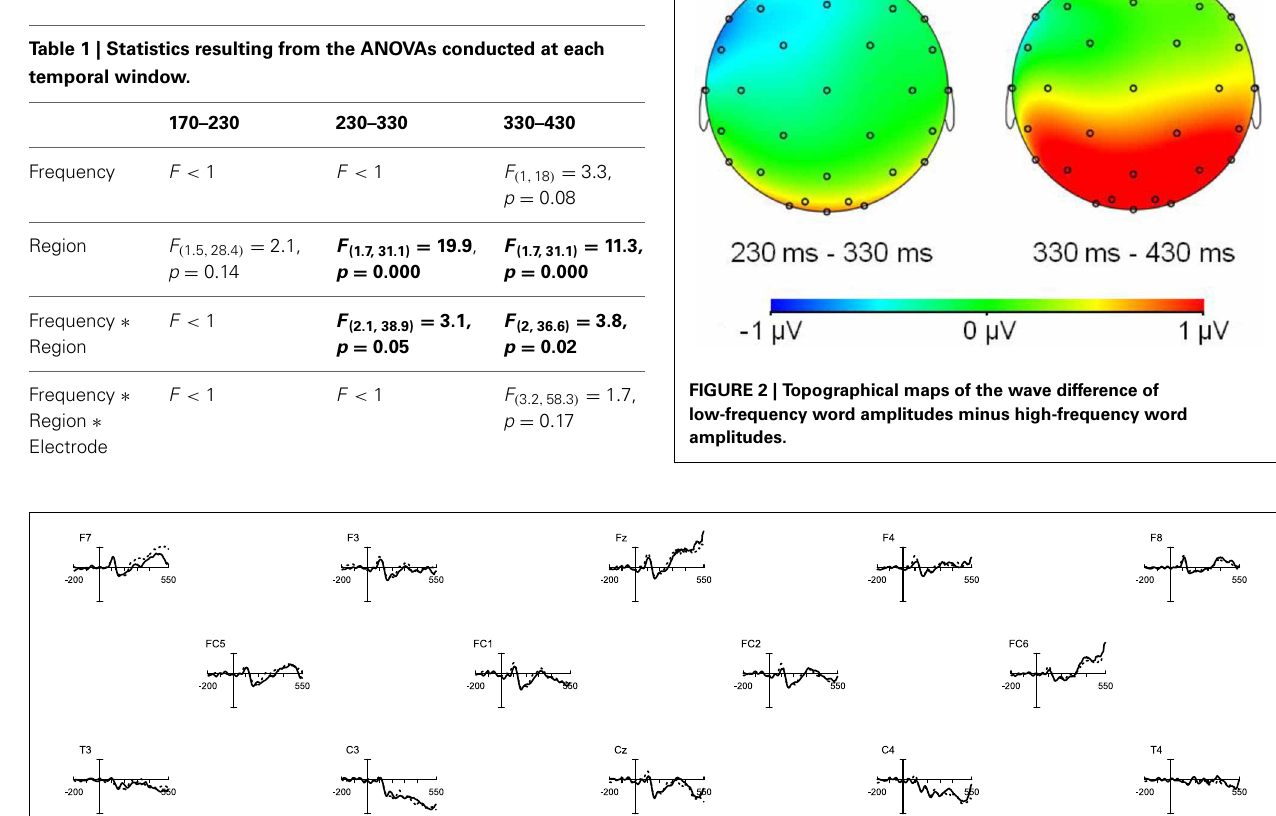
Frontiers in Psychology | Cognitive